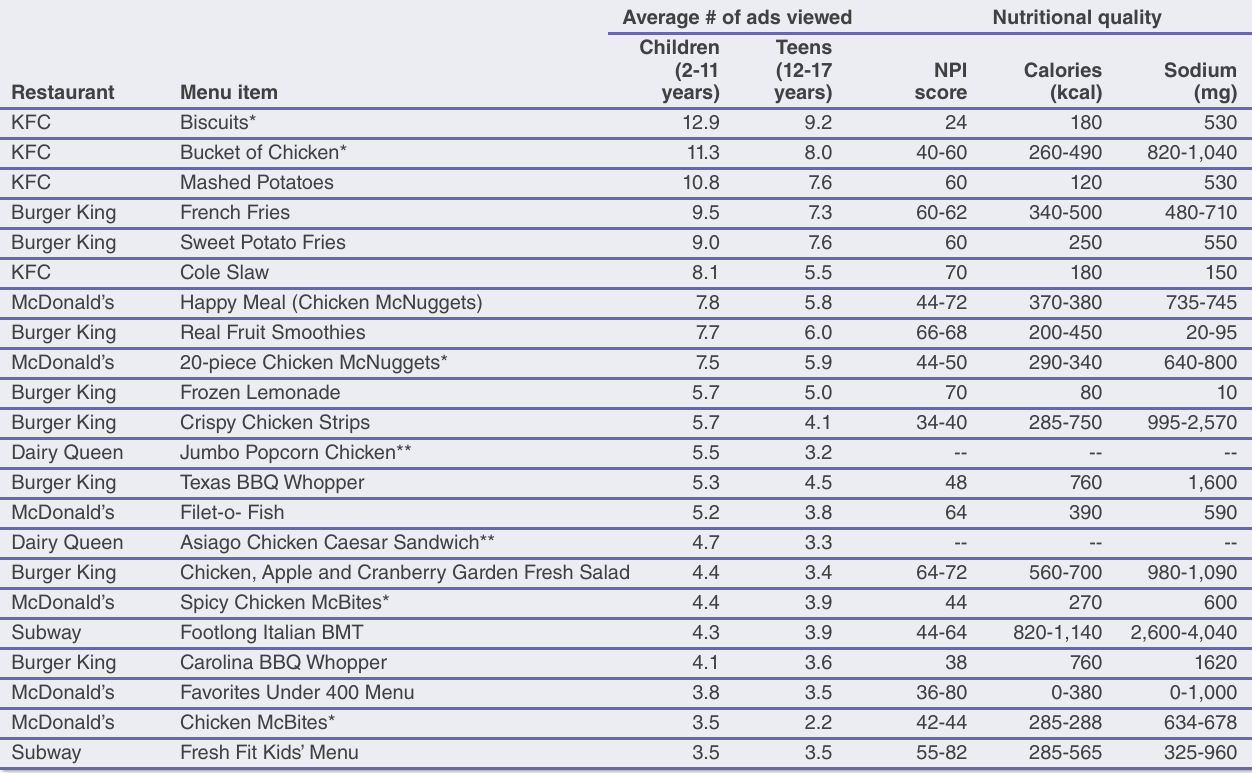
Table 40. Twenty individual menu items viewed most often by Hispanic youth in ads on Spanish-language